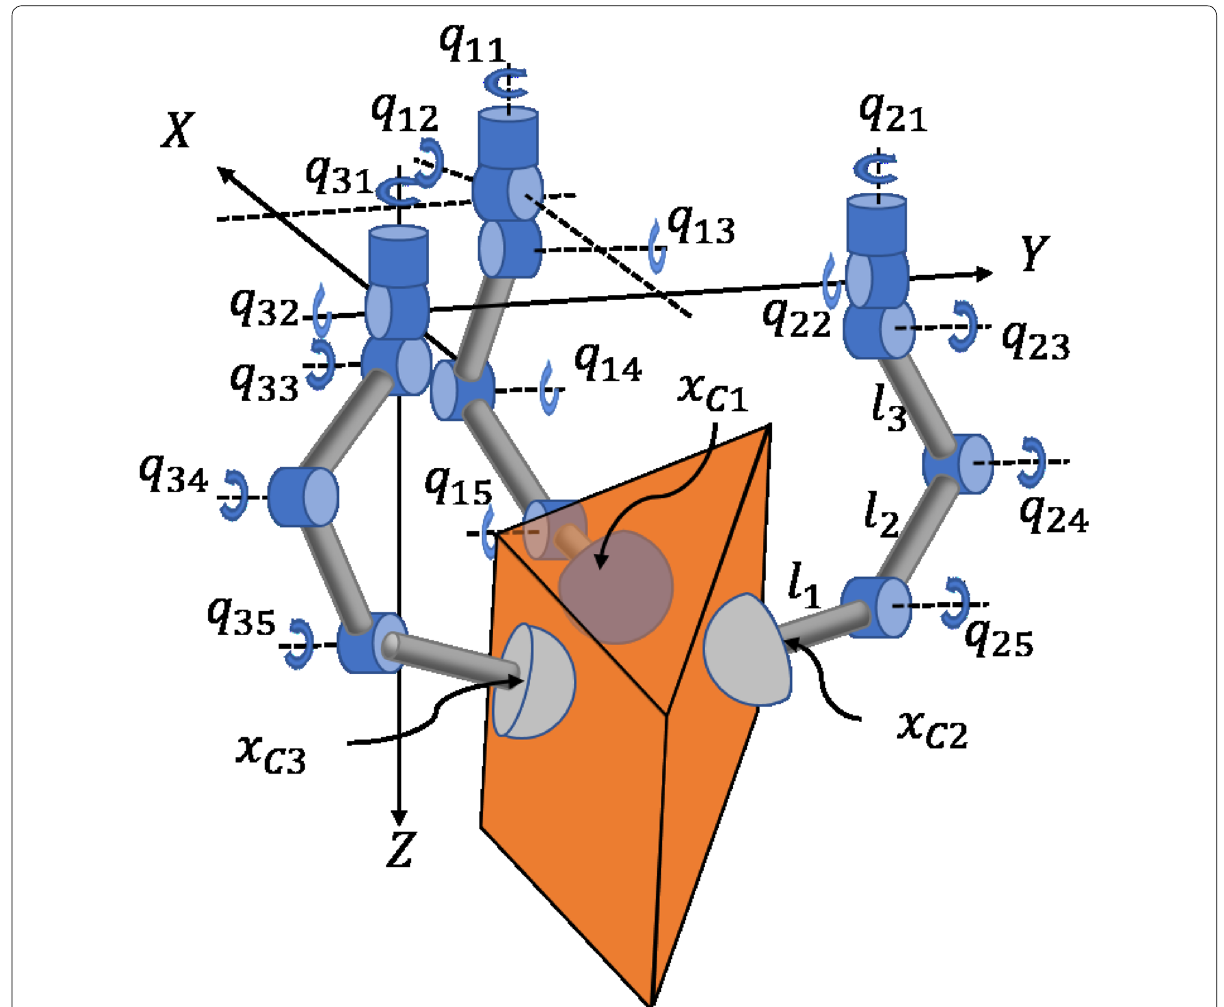
Fig. 13 Multi‑fingered robotic hand system